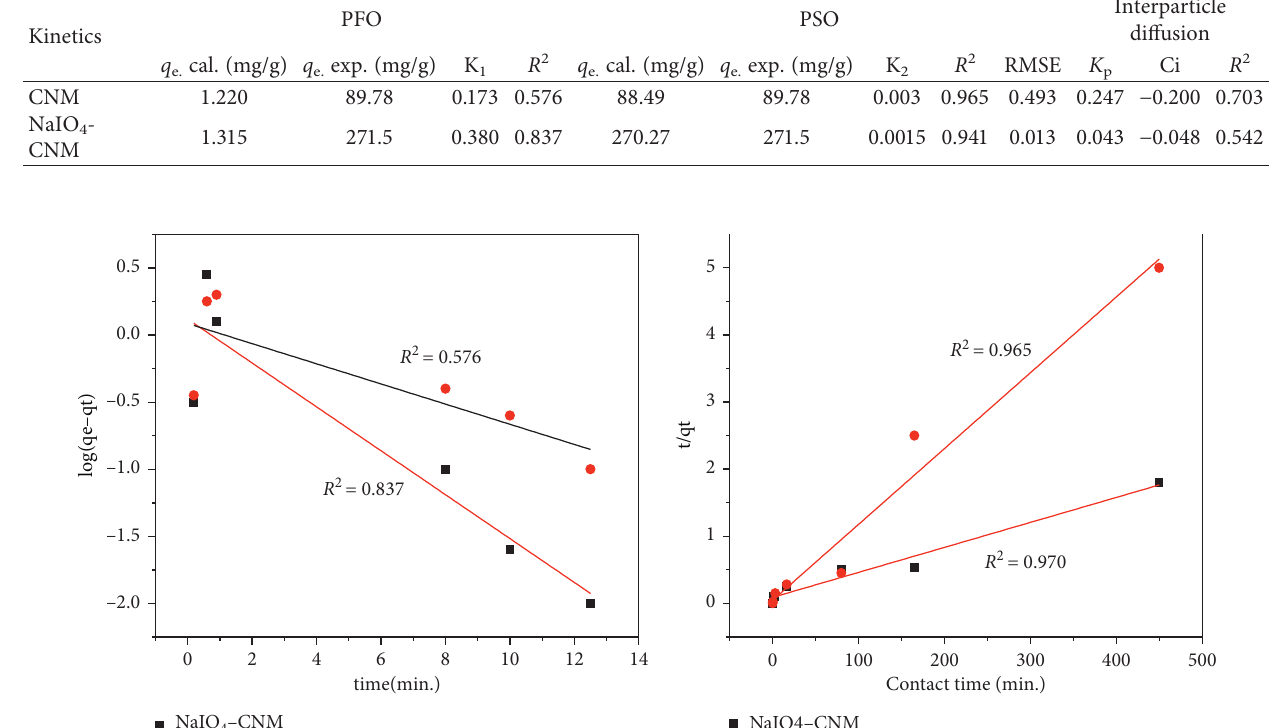
Interparticle diffusion